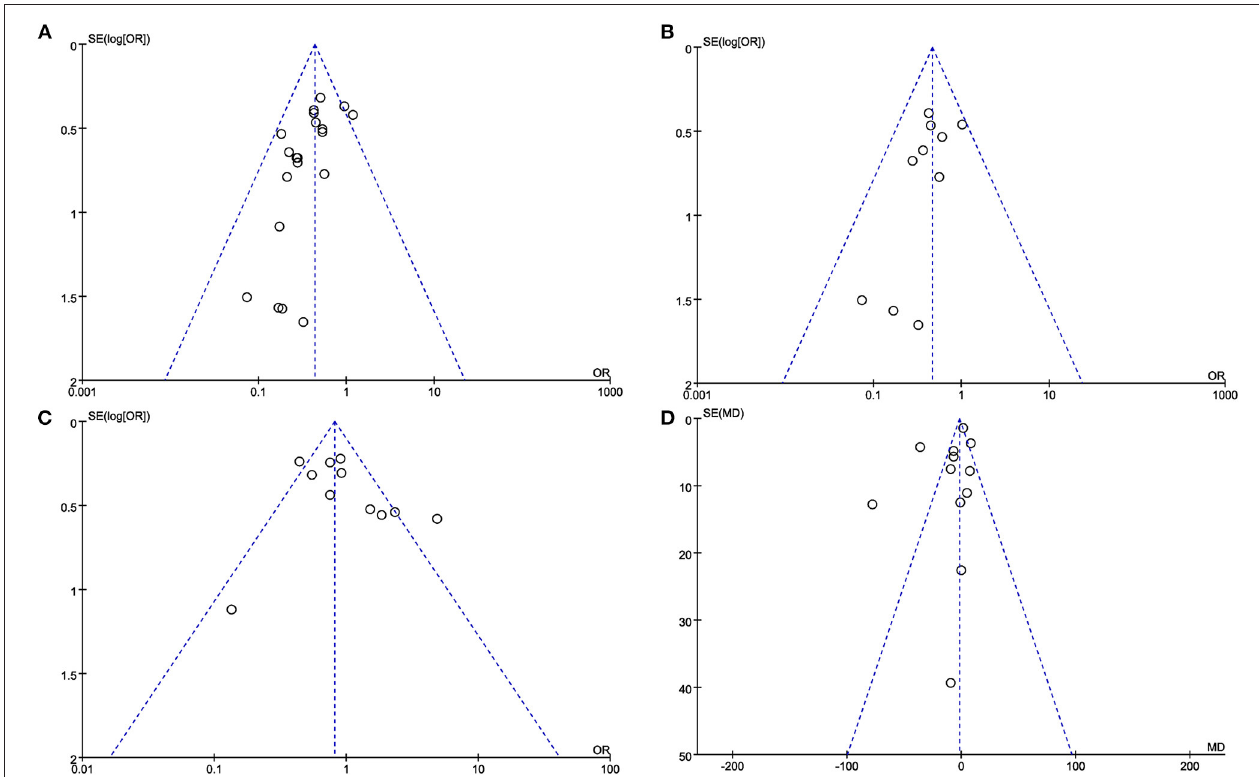
FIGURE 10 | The funnel plot of (A) AL rate. (B) SAL rate. (C) Postoperative complications. (D) Blood loss during